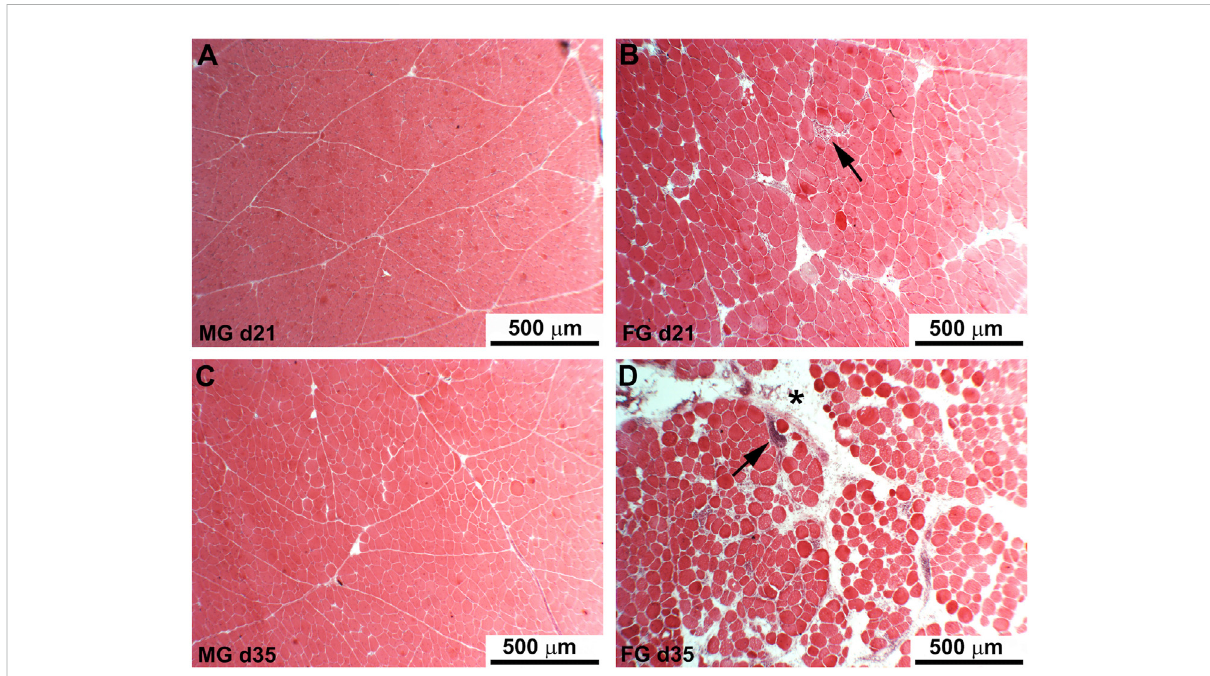
FIGURE 1 Hematoxylin and eosin staining of the Pectoralis major muscles of medium-growing chickens (21 and 35 days old, respectively) show fi bers having a regular polygonal pro fi le surrounded by normal endomysium and perimysium without any detectable damage or additional deposit of intermuscular adipose tissue (A,C) . In fast-growing chickens (B,D) many of the fi bers exhibited rounded pro fi le and variable diameter along with the presence of abundant adipose tissue in fi ltrated at endomysial and perimysial (D, asterisk) levels. Arrows indicate necrotic fi bers surrounded by in fl ammatory in fi